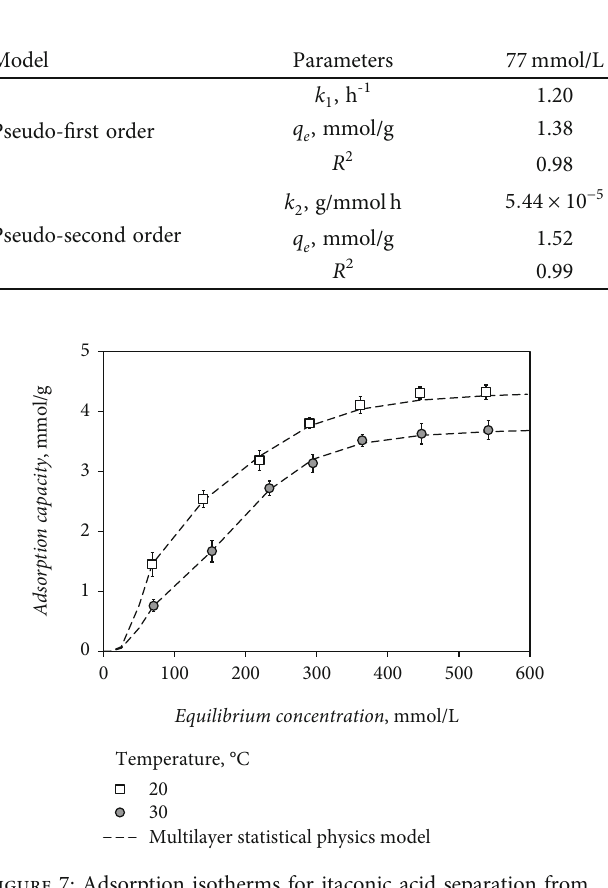
Figure 7: Adsorption isotherms for itaconic acid separation from aqueous solution at